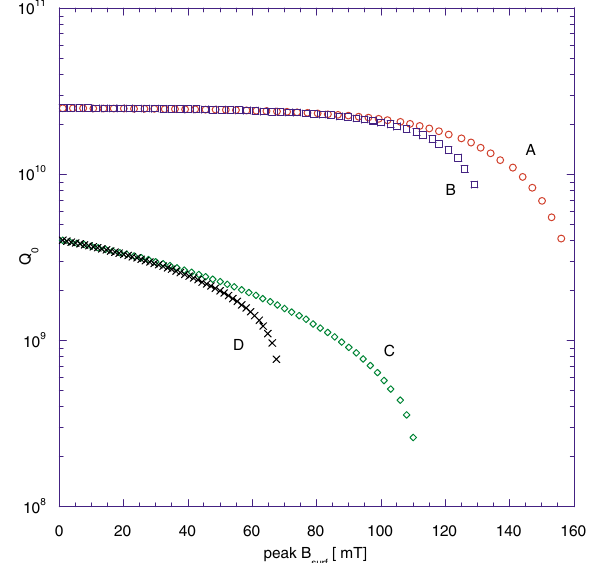
FIG. 6. (Color) Pipes position relative to the magnitude of the magnetic field on the surface. Each pipe has a diameter of approximately 6 cm.